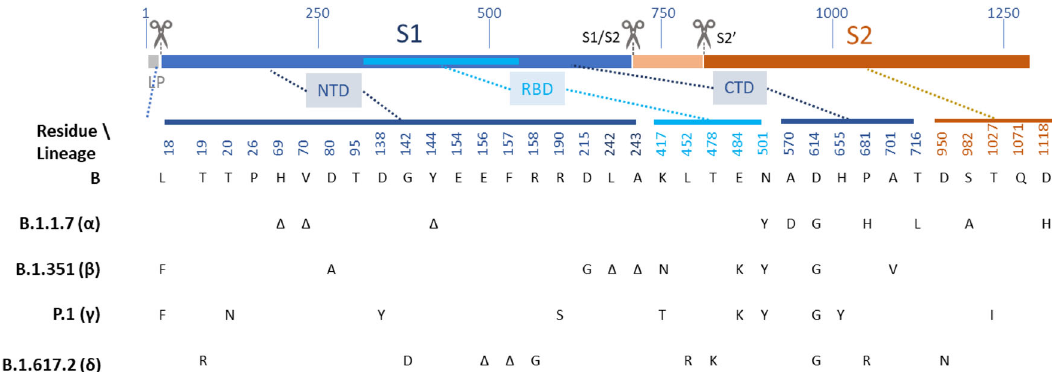
Fig. 1 Sequence variation in spike glycoprotein. The open reading frame encoding spike (S) is illustrated, with the position of key features of processing and function indicated to approximate scale (residue number indicated above). During co-translational translocation to the endoplasmic reticulum (ER), the short leader peptide (LP) is proteolytically removed. Following folding, trimer assembly and glycosylation in the ER and Golgi, the trans -Golgi localized protease, furin, cleaves the boundary between the S1 and S2 polypeptides. Following binding of the receptor-binding domain (RBD, cyan) to ACE2 on host cells, cell-surface TMPRSS2 proteolytically cleaves the S2 ’ site, facilitating conformational changes to spike that result in fusion of the virus envelope with the plasma membrane. Variant residue positions are indicated below, and their approximate location on the S polypeptide is indicated. Residue identities are shown at each of these positions for a prototype lineage B isolate, and at each position in four lineages of interest, B.1.1.7 ( α — Alpha), B.1.351 ( β — Beta), P.1 ( γ — Gamma) and B.1.617 ( δ — Delta), at which the respective lineage differs from prototype. Δ indicates deletion of one or more residues.